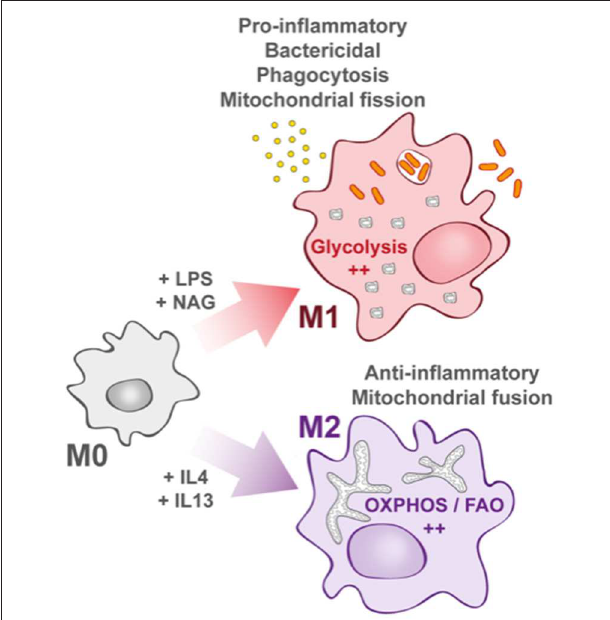
FIGURE 1 | Macrophage activation upon bacterial infection. Quiescent macrophages (M0) have the ability to polarize into two antagonist cell types. At early steps of infection, M0 macrophages differentiate into M1 macrophages (upper part) that display a pro-inflammatory profile. They support highly efficient pathogen killing. This phenotype is associated with glycolysis induction. In contrast and later during infection, M0 macrophages can also differentiate into M2 macrophages (lower part). They rely on oxidative phosphorylation (OXPHOS) and fatty acid oxidation (FAO). They help in inflammation